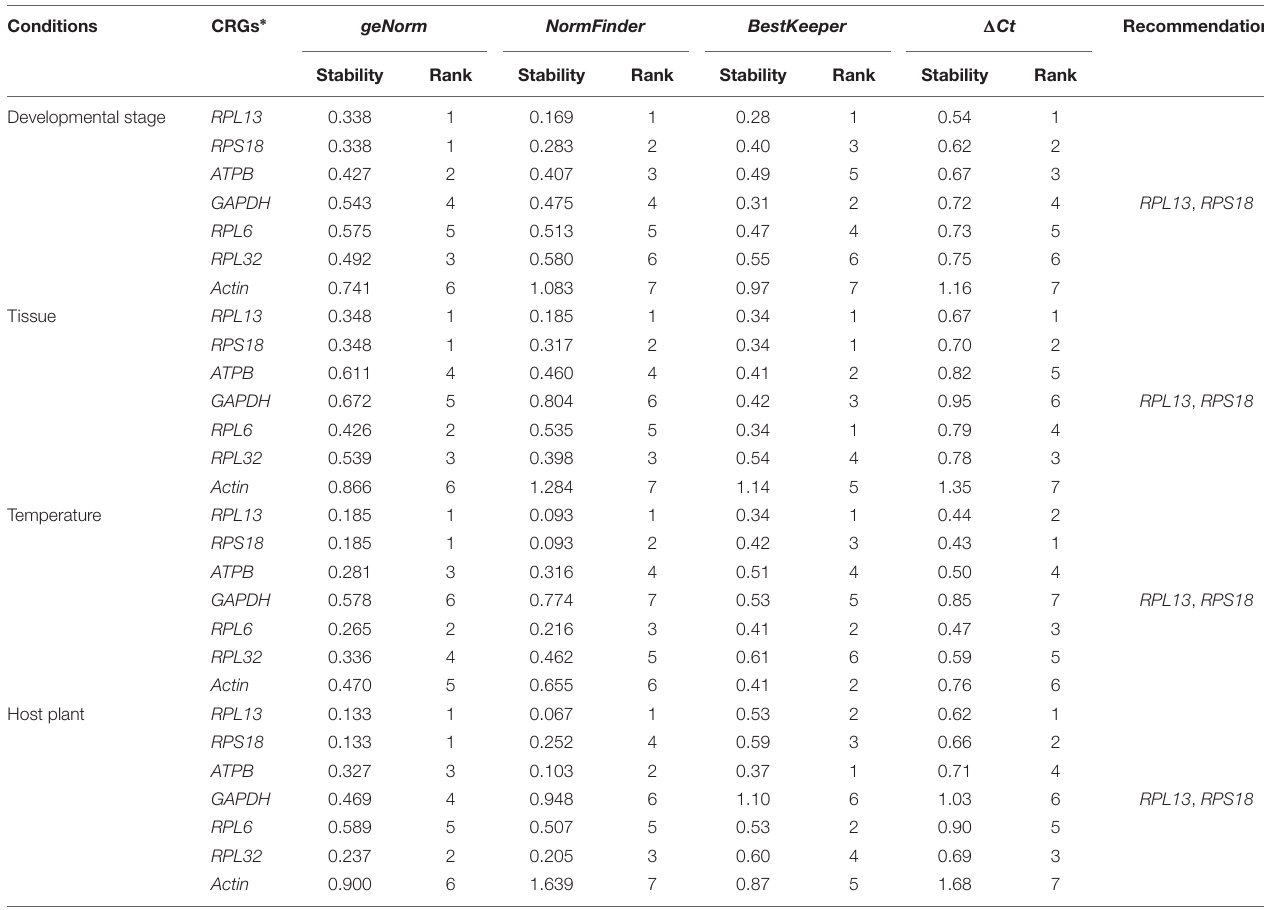
TABLE 2 | Stability of 7 candidate reference gene expression in H. vigintioctomaculata under different experimental conditions calculated by the 4 different analytical tools geNorm , Normfinder , BestKeeper , and the (cid:49) Ct method, respectively.